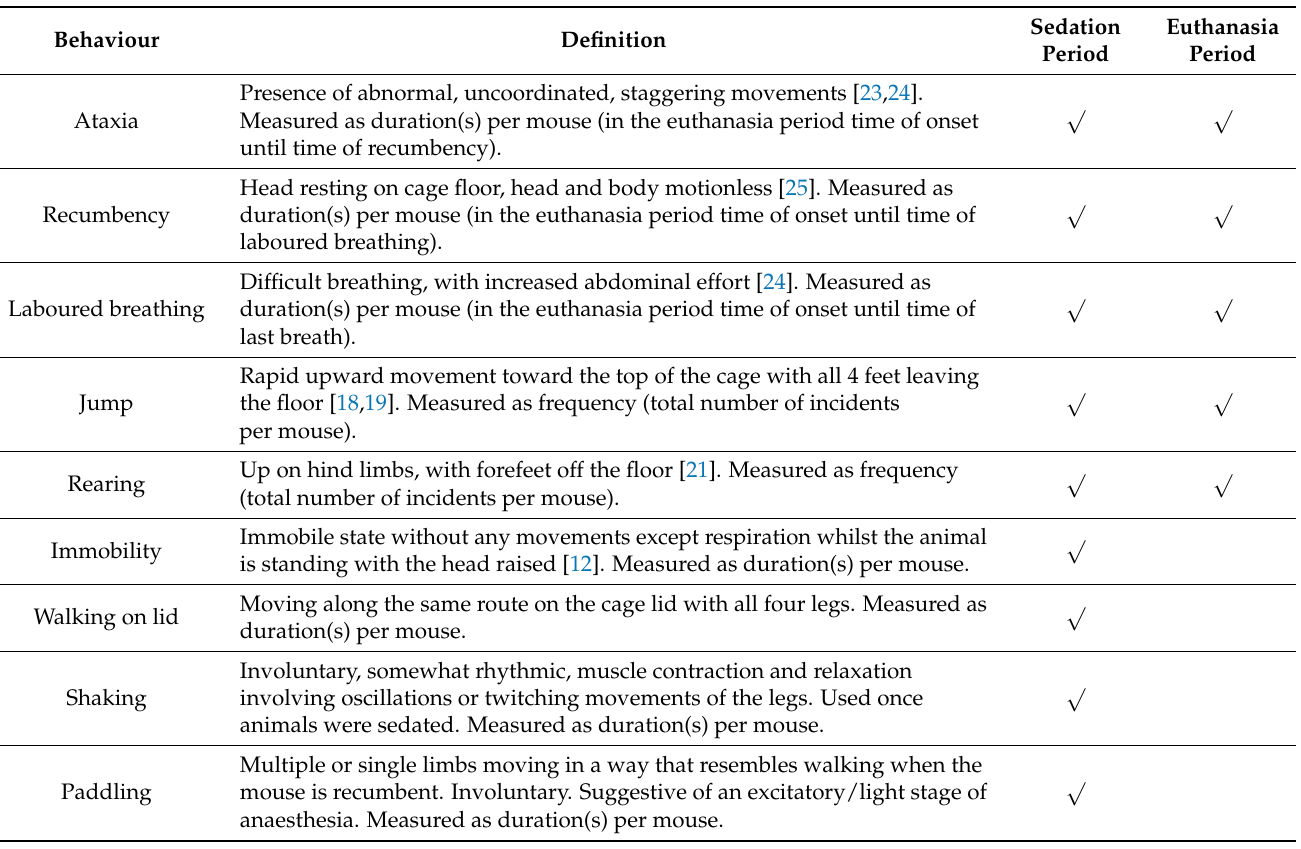
Table 1. Ethogram for coding sedation and aversive behaviours during sedation (pre-euthanasia) and euthanasia periods in C57BL/6 mice.